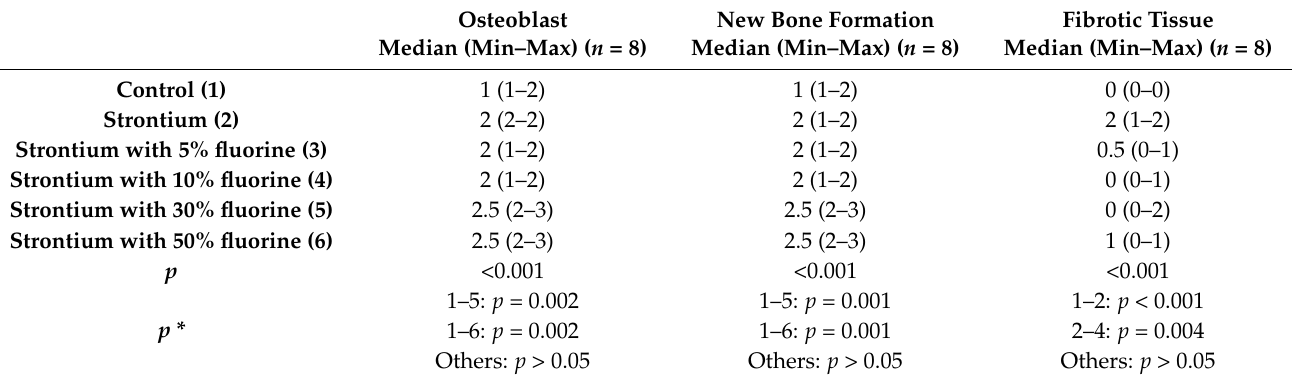
Table 3. Intergroup comparison of variables.